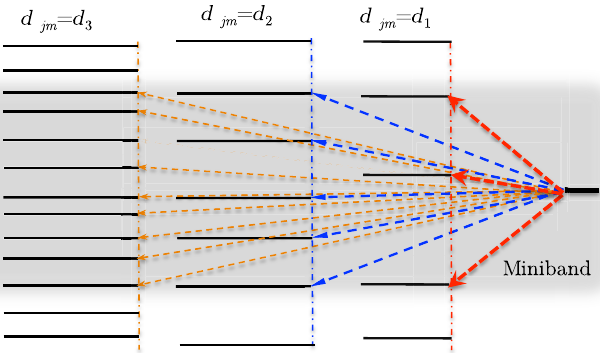
FIG. 14. Cartoon of the energies of the marked states ϵ within m the impurity band. Energy levels are shown with solid black lines forming groups arranged vertically. All states j z within one m i d from a given group lie at the same Hamming distance d jm ¼ state j z with d increasing from right to left. The energy level ϵ j i j is depicted at the right side of the figure with a thick black line. Arrows depict the transitions away from the initial state j ψ ð 0 Þi ¼ j z j i into the marked states j z m i whose energy levels lie inside the miniband of the width Γ centered at ϵ ; i.e., they satisfy the j j − ϵ ≲ Γ condition j ϵ . The miniband width is indicated with j m j j the gray shading area. Arrows of the same color depict transitions within one decay channel, connecting the state j z to the states a j i Hamming distance d away from it. Smaller values of d corre- spond to bigger typical level spacings δϵ d [Eq. (87)] and j fewer states in a miniband Ω [Eq. (98)] within the decay d channel given by d